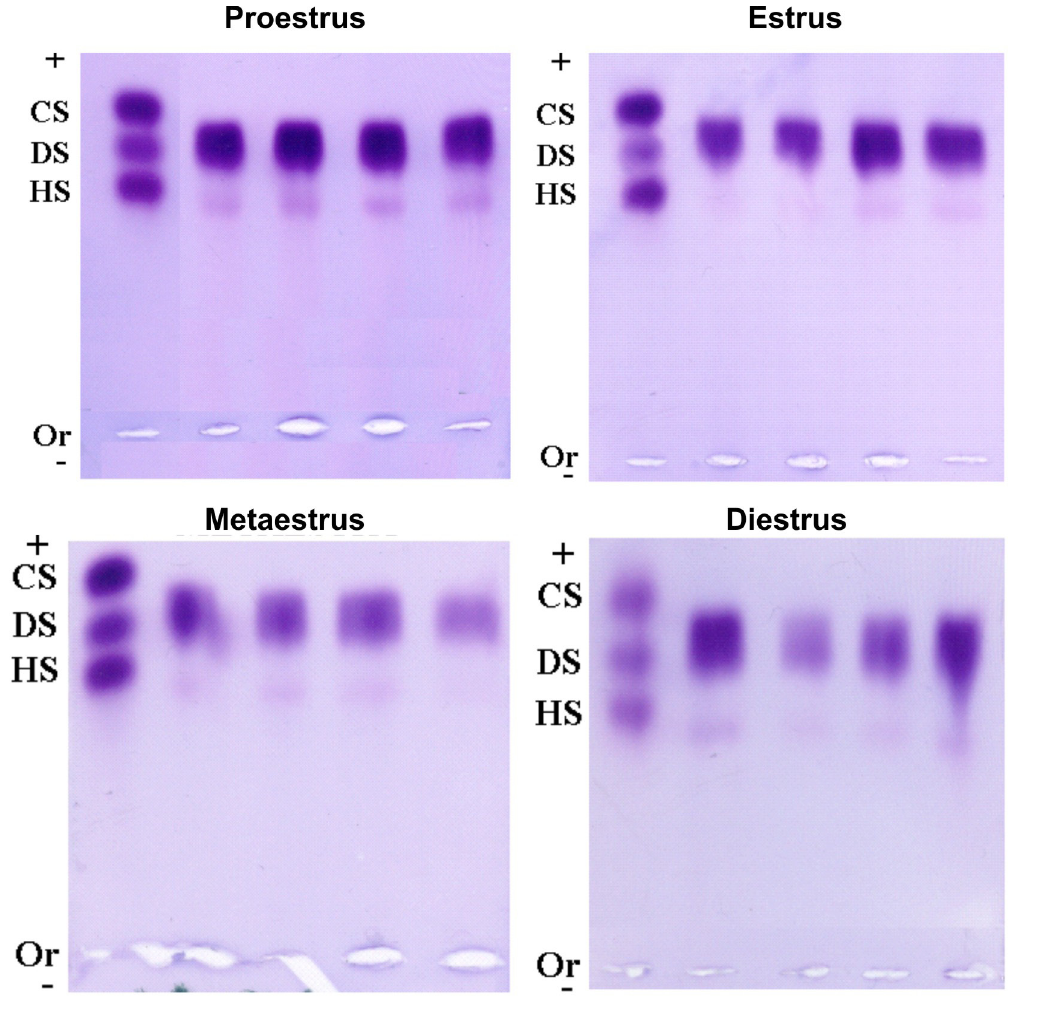
Figure 1 - Typical electrophoretic pattern of sulfated glycosaminoglycans of the rat uterine cervix at each phase of the estrous cycle. Legends: CS = chon- droitin sulfate; DS = dermatan sulfate; HS = heparan sulfate; Or = origin (at the negative